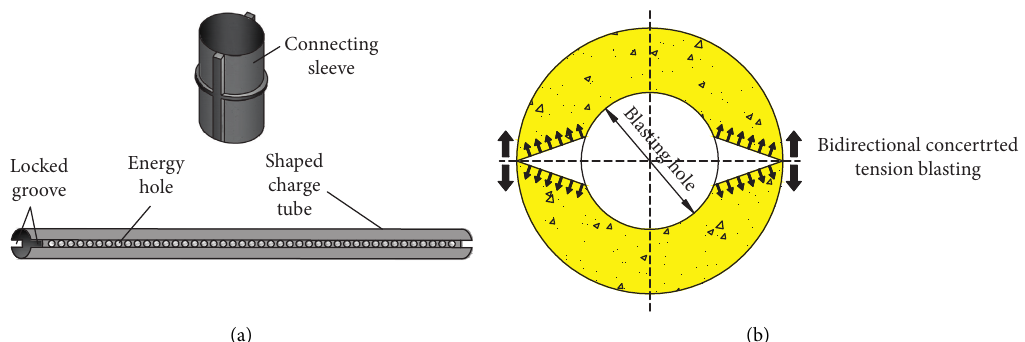
Figure 3: Devices and principle of bilateral bidirectional shaped charge tension blasting technology. (a) Connecting sleeve and shaped charge tube. (b) Blasting